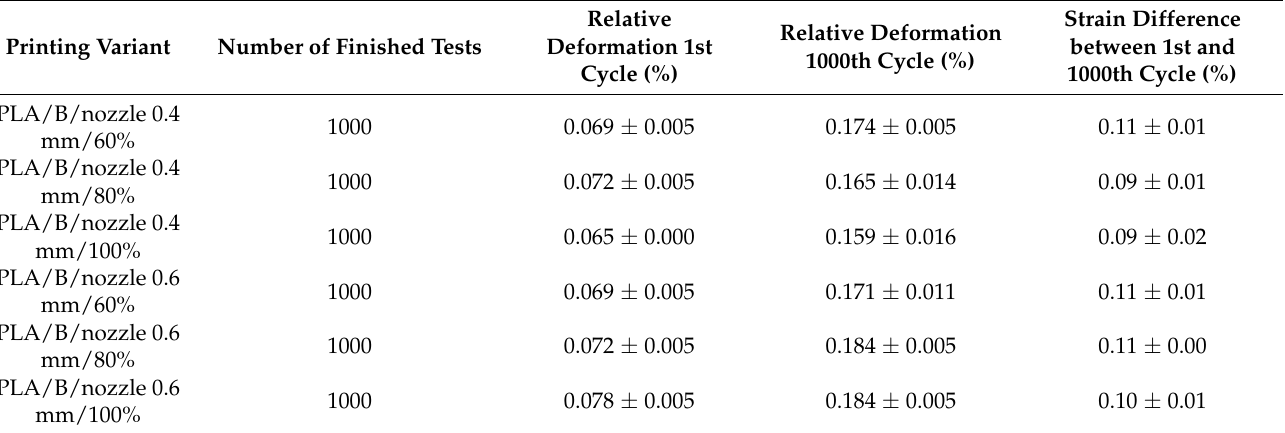
Figure 6. Effect of infill density on tensile strength in low-cycle testing using FDM 3D printing with different nozzle diameters. Table 3. Results of deformation of the test samples between the first and last test cycles in the low-cycle